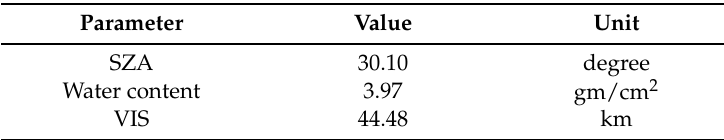
Figure 5. Airborne hyperspectral imagery acquired with an AISA sensor, shown as a true-color composite. Different plants are marked in the figure: 1: ailanthus; 2: elm; 3: mountain peach; 4: willow; and 5: Chinese ash. Table 8. The retrieved parameters by CE318.